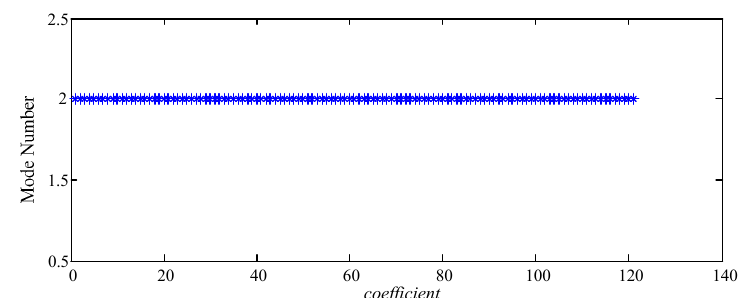
Figure 7. The distribution diagram of mode numbers based on the simulated signal.